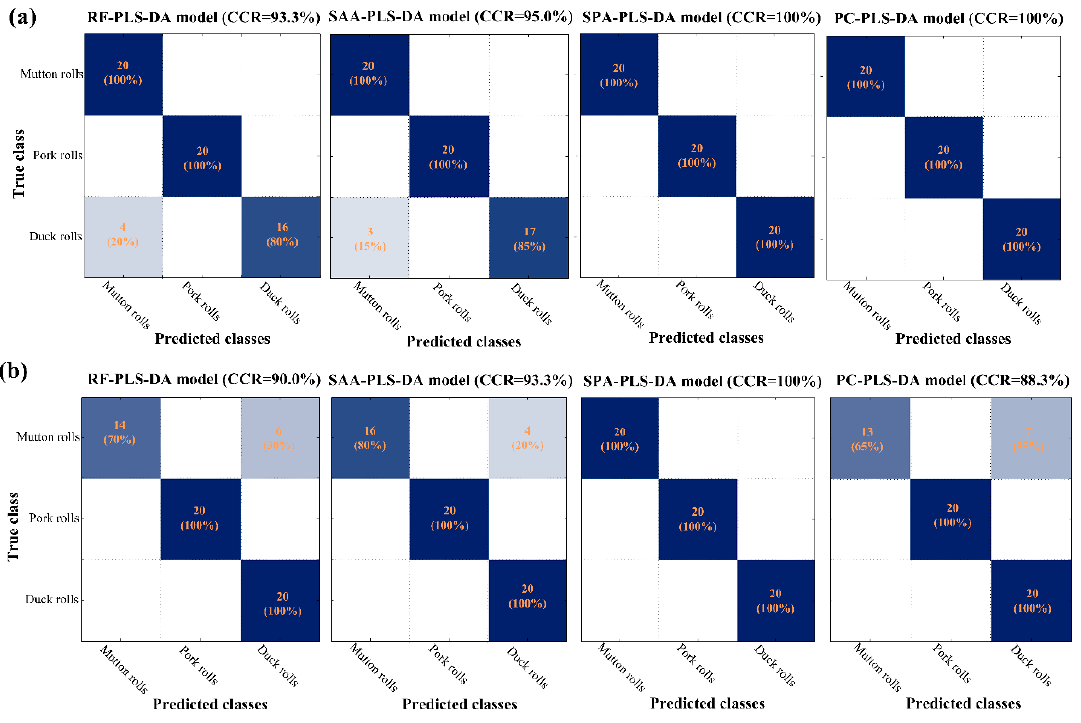
Figure 5. Confusion matrices in prediction set of PLS-DA models developed by various methods-selected wavelengths for ( a ) raw and ( b ) cooked meat rolls classification. RF: random frog; SAA: simulated annealing algorithm; SPA, successive projections algorithm; PC, principal component; PLS-DA: partial least squares-discriminant analysis.